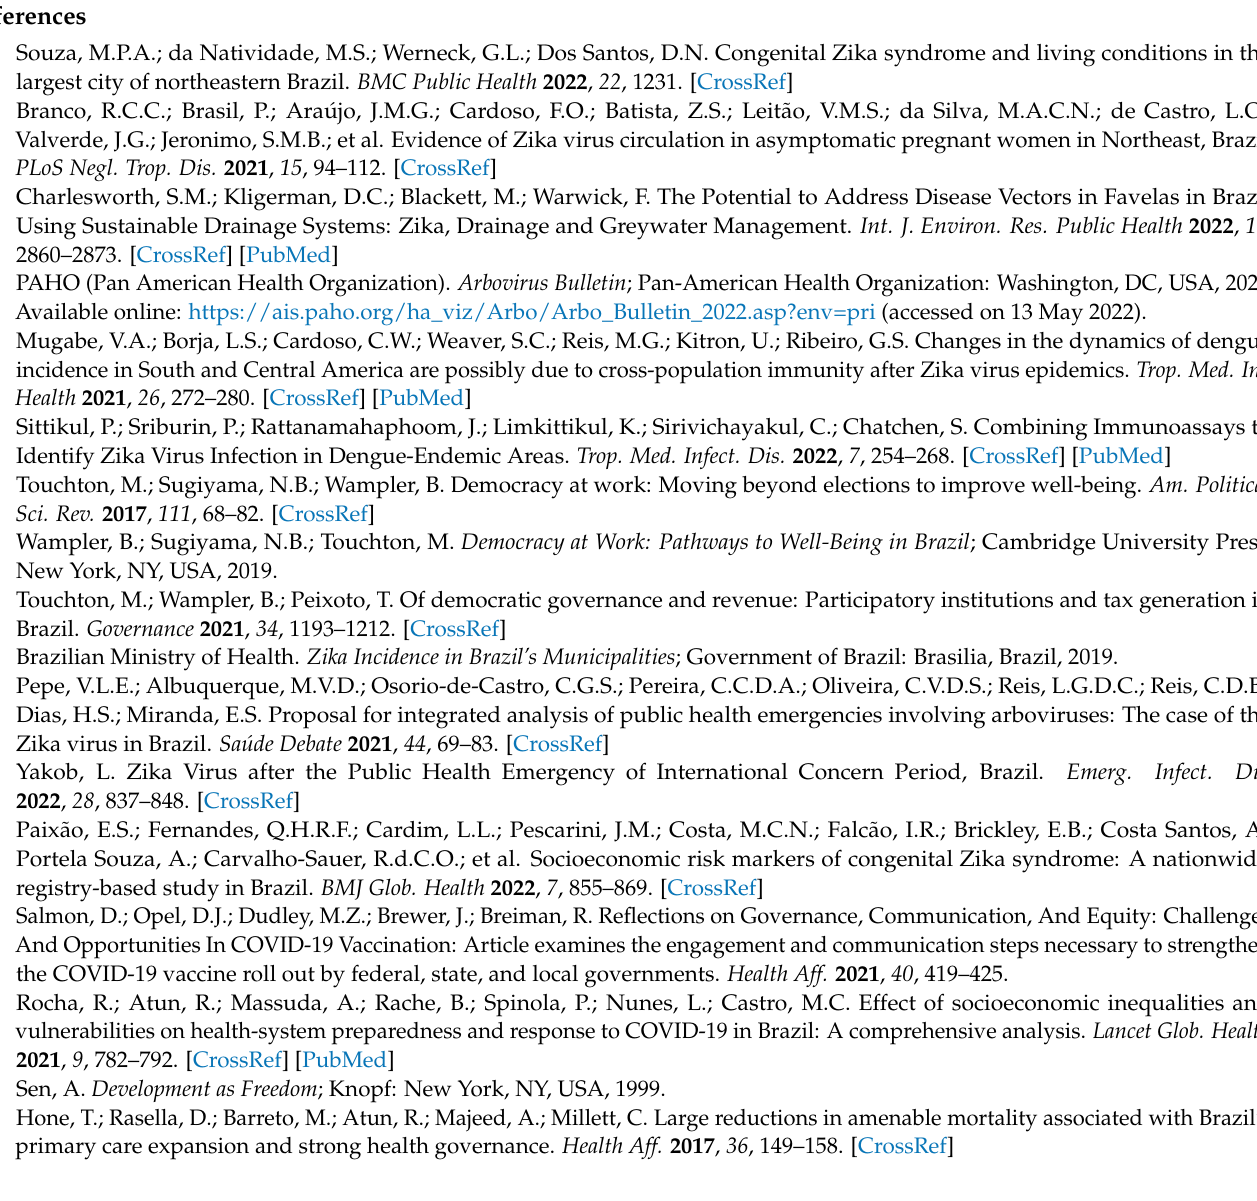
councils and health spending. Table S6: OLS Regression with Interactions between